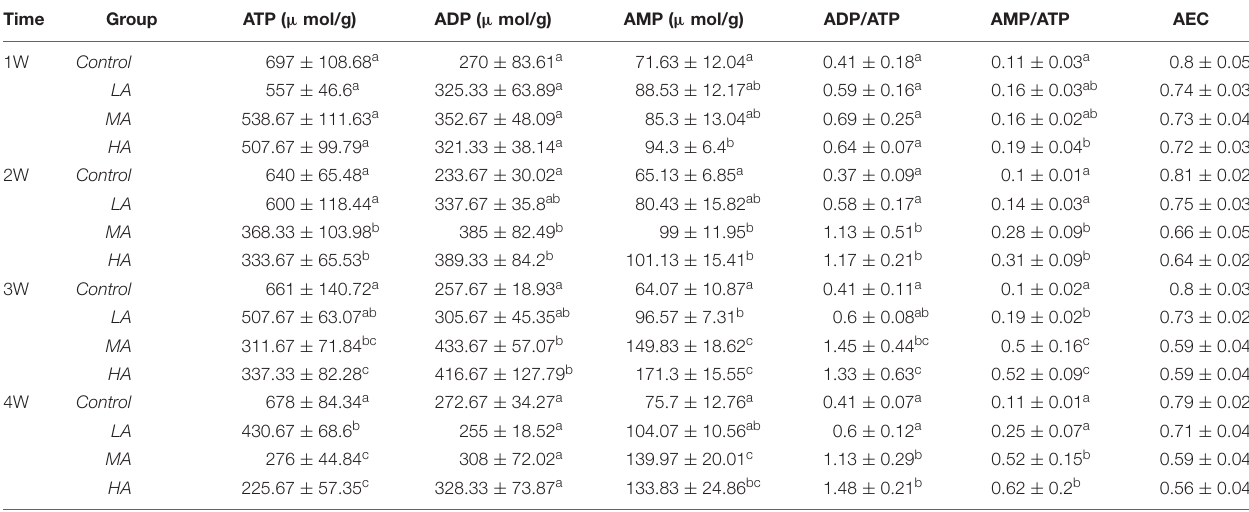
TABLE 2 | Adenine nucleotides in the gills of P. trituberculatus in different groups during long-term ammonia stress.